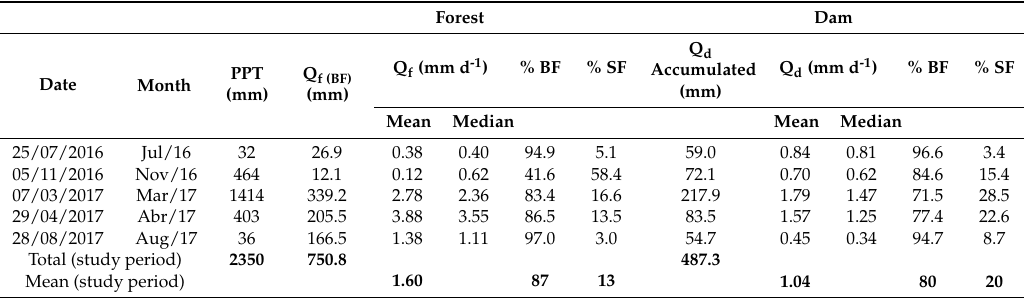
Table 1. Cumulative monthly precipitation (PPT) and discharge (Q d for Dam and Q f for Forest catchments), mean and median daily discharge, percent baseflow (BF) and stormflow (SF) with the discharge for hydrological months in pasture catchments at the research site.